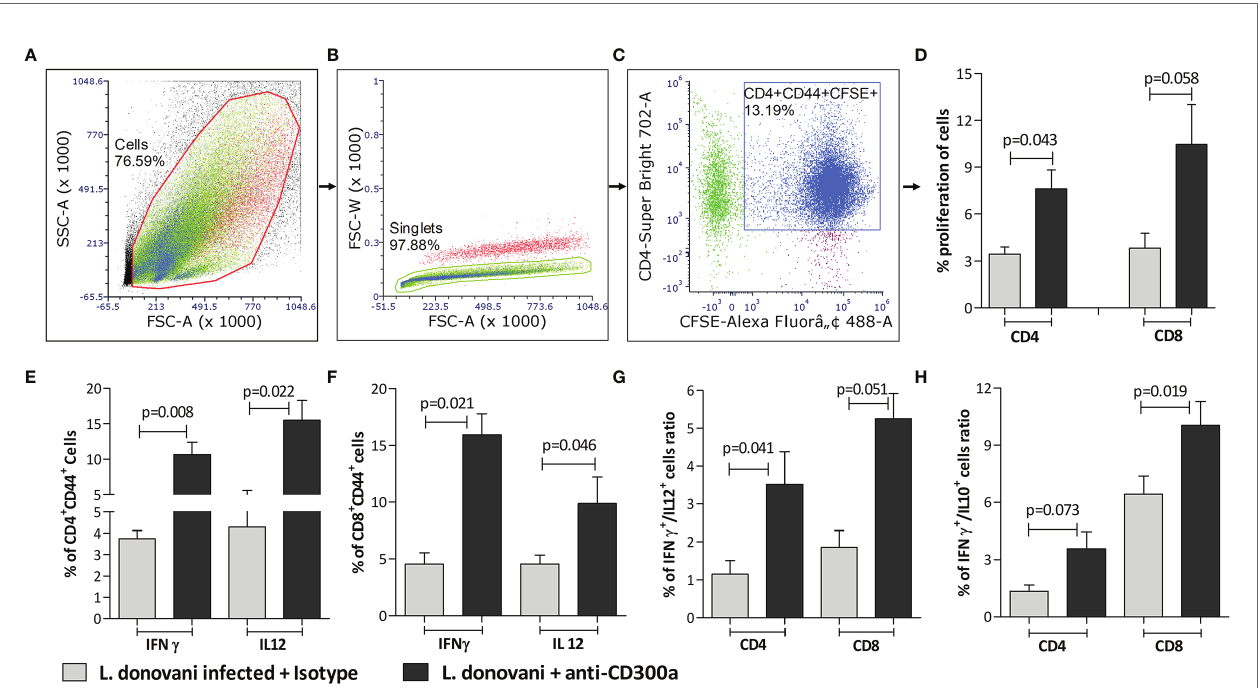
FIGURE 4 | The proliferation rate and cytokines production of antigen experienced CD4 + and CD8 + T cells co-cultured with anti-CD300a antibodies treated and parasites infected BMDCs. To quantify T cells proliferation, the CFSE stained pan T cells isolated from splenocytes of animals after 14 days post-infection, were cultured with BMDCs (1:10; DCs to T cells ratio). A representation of gating strategies to quantify the percent of antigen experienced CFSE + CD4 + /CD8 + T cells is depicted in panels (A-C) . The CD4 + and CD8 + T cells cultured with anti-CD300a treated and parasite infected BMDCs were found more proliferative in comparison to the cells cultured with untreated BMDCs (D) . The CD300a receptor blocking signi fi cantly increased the production of IFN- g and IL-12 in antigen experienced T cells (E, F) . The blocking of CD300as receptors also enhanced IFN- g + /IL-12 + producing T cells (G) , and improved their IFN- g /IL-10 ratio (H) . The cytokines positive T cells were measured on CD4 + CD44 + T cells that were gated on CD3 + T cells and isotype antibodies were used as a control to determine statistical signi fi